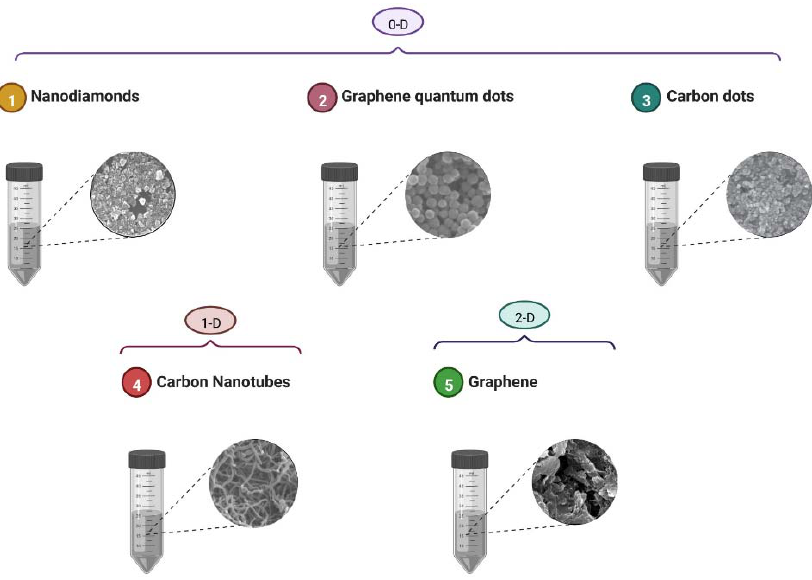
Figure 2. Nanoforms of carbon ‐ based materials with examples for 0 ‐ D, 1 ‐ D, and 2 ‐ D carbon nanostruc ‐ tures.